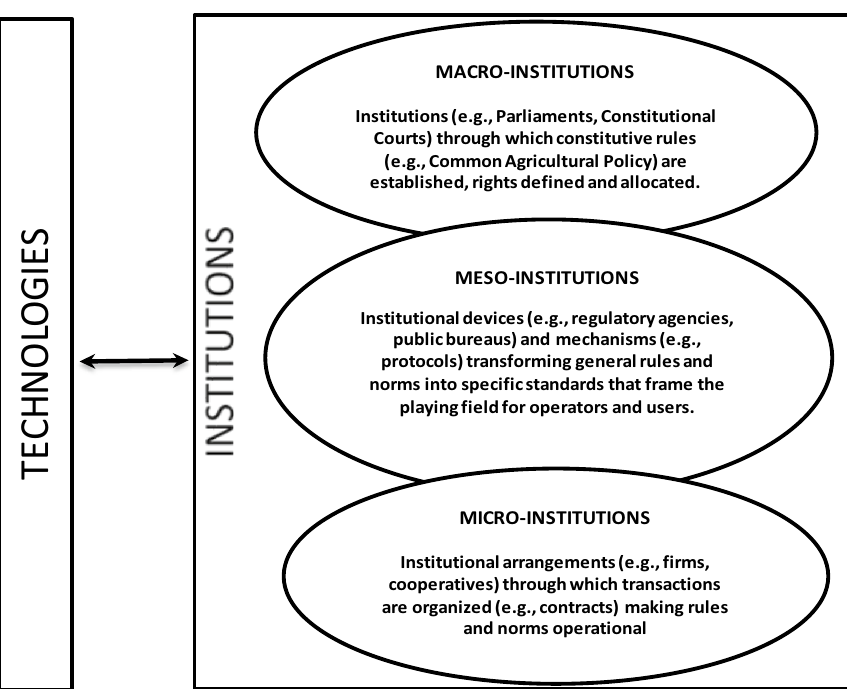
Fig. 1 Institutional layers, their overlapping areas and their interdependence with